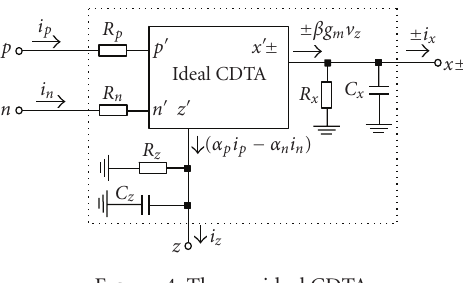
Figure 4: The nonideal CDTA. Table 1: Aspect ratios of the MOS in Figure